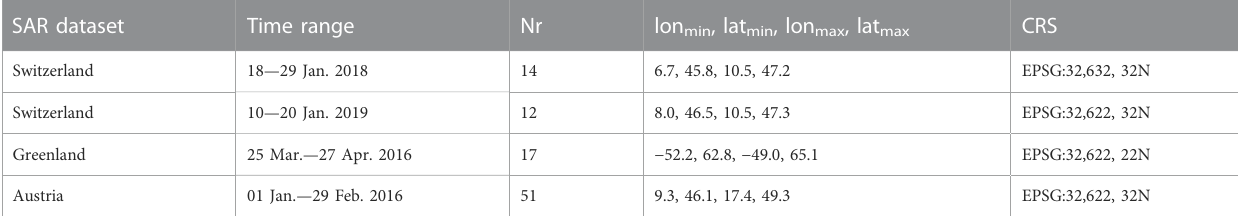
TABLE 1 SAR images that cover the time range and area of the training data as well as additional images that cover Austria. “ Nr. ” indicates the number of images, minimum and maximum longitudes and latitudes, lon min , lat min , lon max , and lat max , indicate the maximum area covered by the SAR images, and “ CRS ” is the coordinate reference system with its corresponding UTM